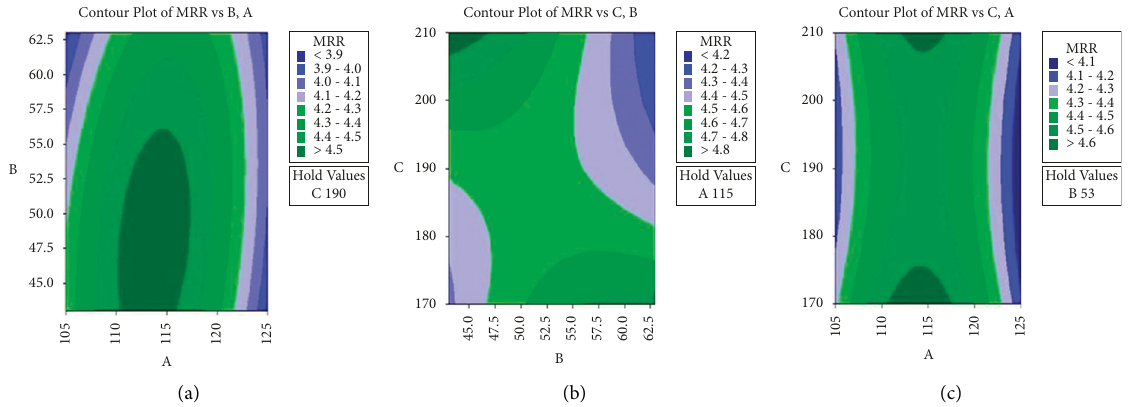
Figure 7: (a) Contour plot Of MRR vs (B) A., (b) contour plot of MRR vs (C) B., and (c) contour plot Of MRR vs C, A.